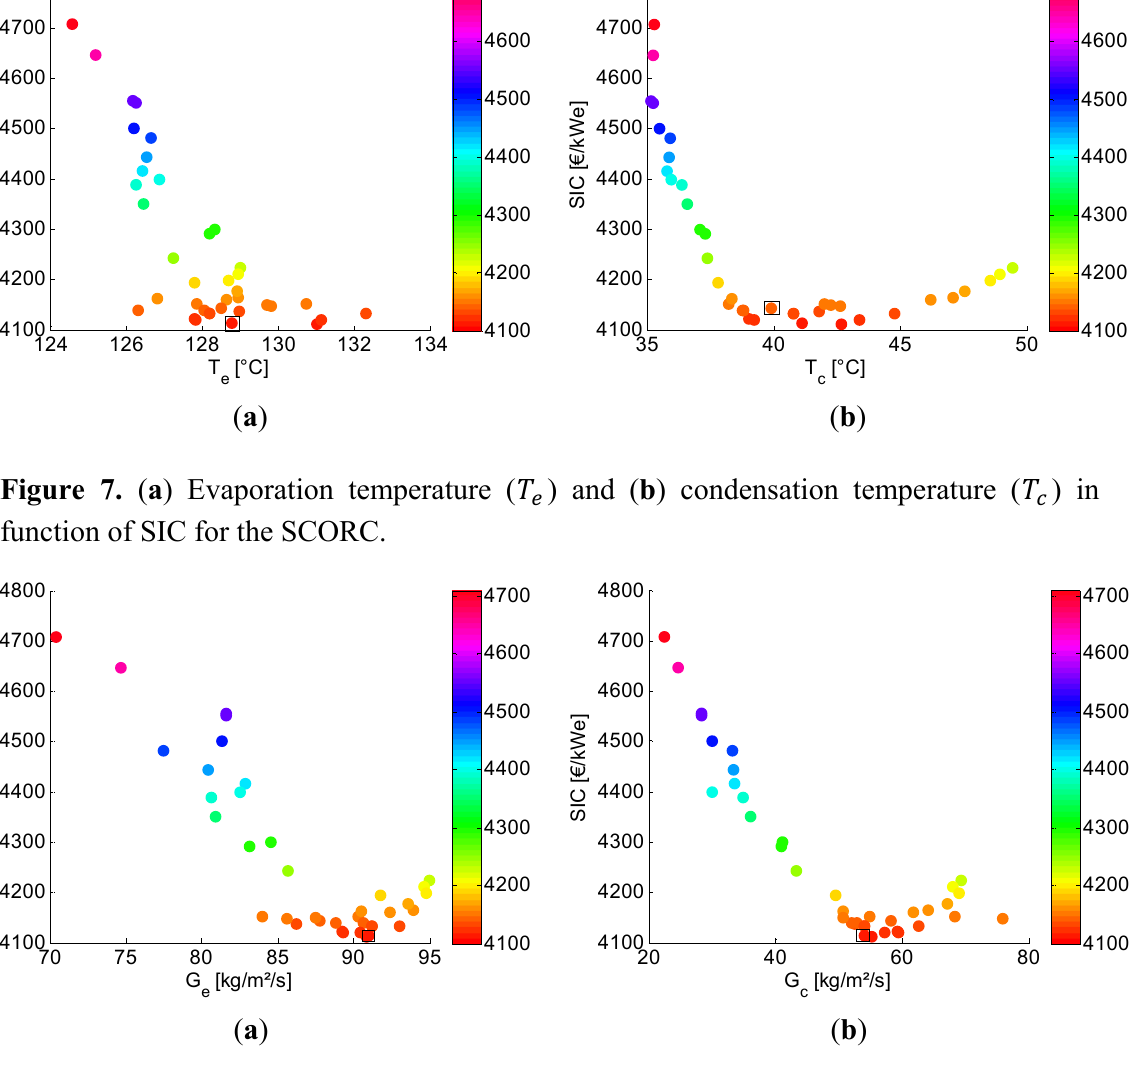
Figure 8. ( a ) Mass flux evaporator ( (cid:1833) SIC for the